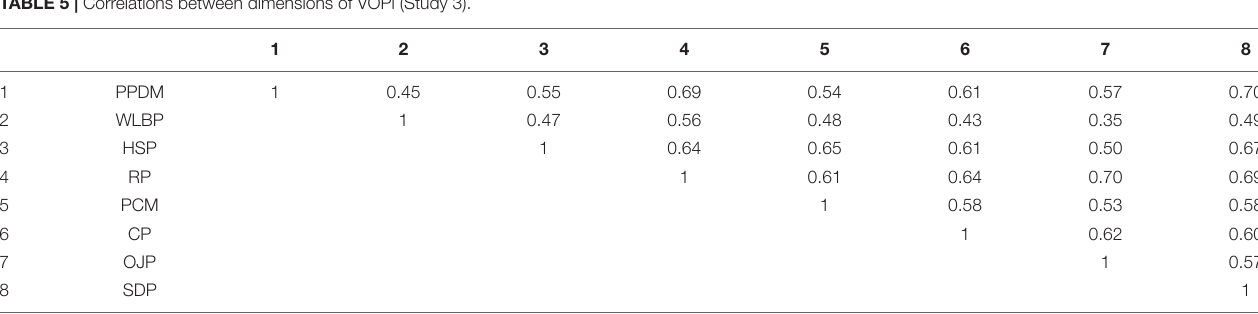
TABLE 5 | Correlations between dimensions of VOPi (Study